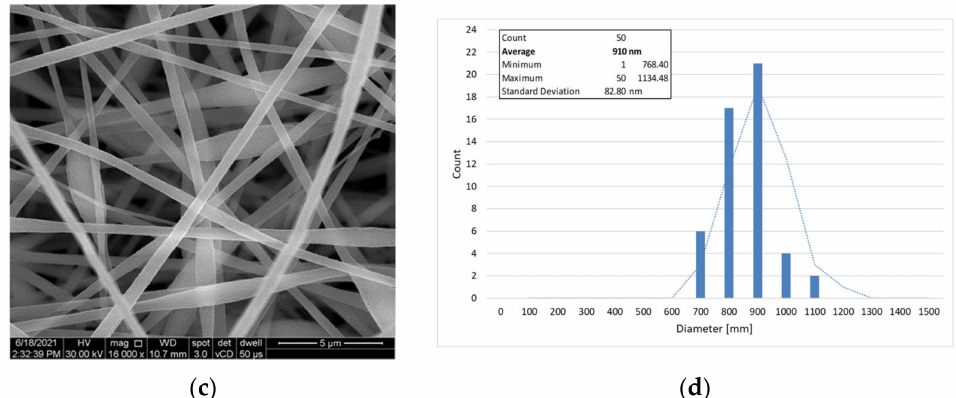
Figure 3. SEM images of initial microvascular network formed by electrospinning at different